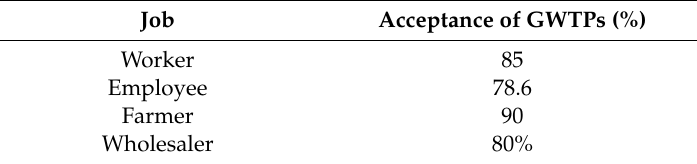
Table 3. Acceptance of GWTPs for reuse in irrigation versus job.